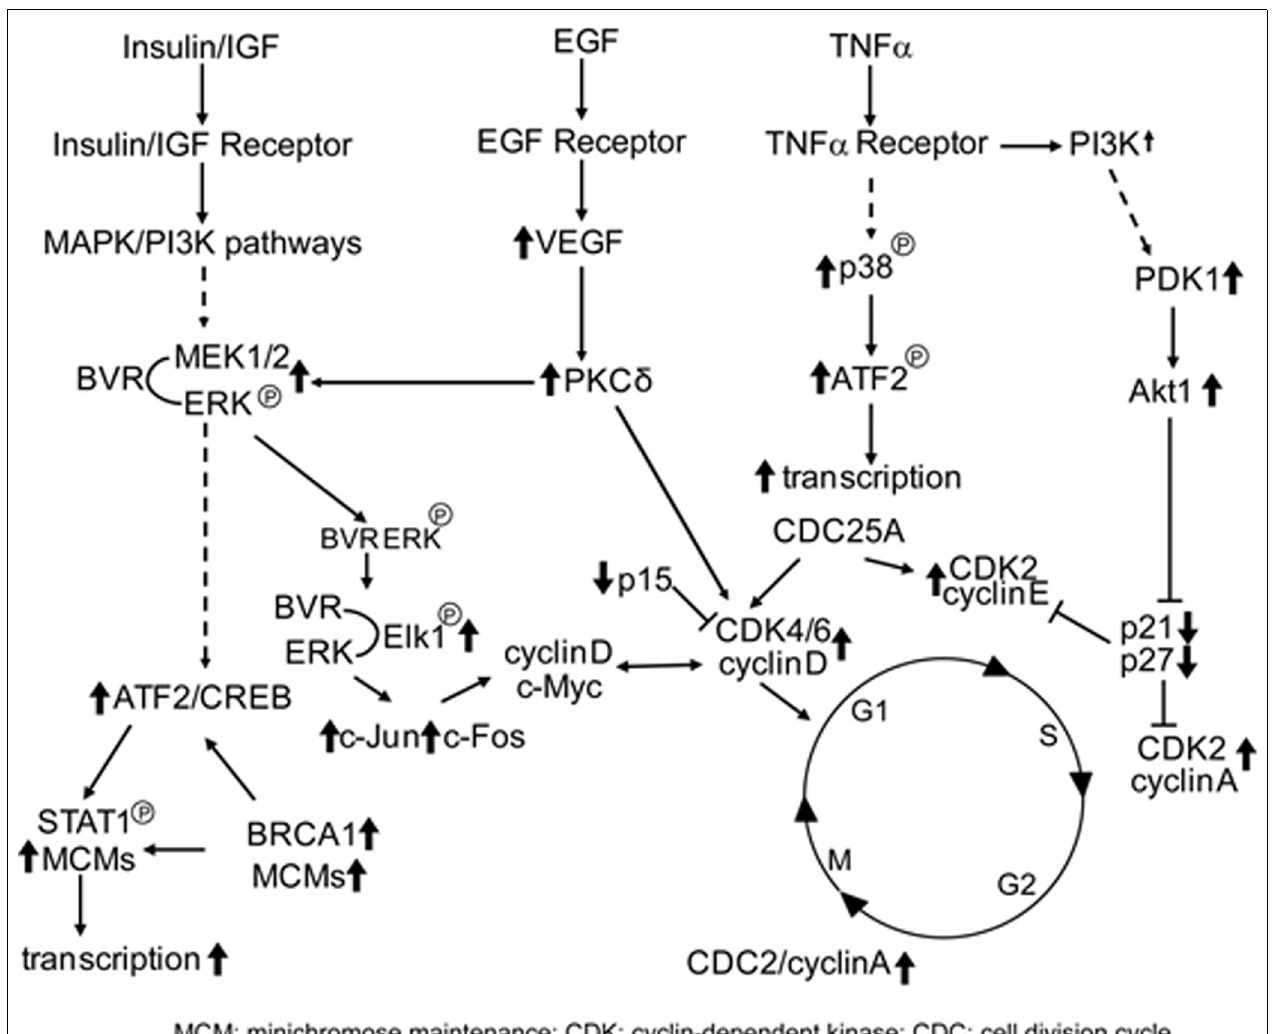
FIGURE 4 | BVR targets in cell cycle activation. Signaling pathways that directly activate the cell cycle and themselves activated by BVR are shown. Those proteins that are activated by BVR or